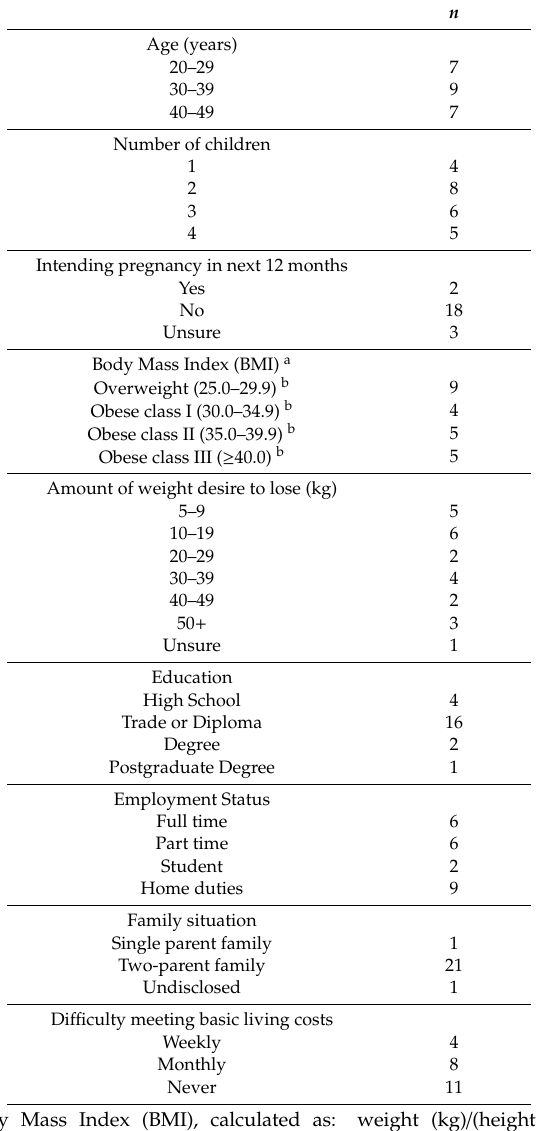
Table 2. Demographic characteristics of participants ( n =